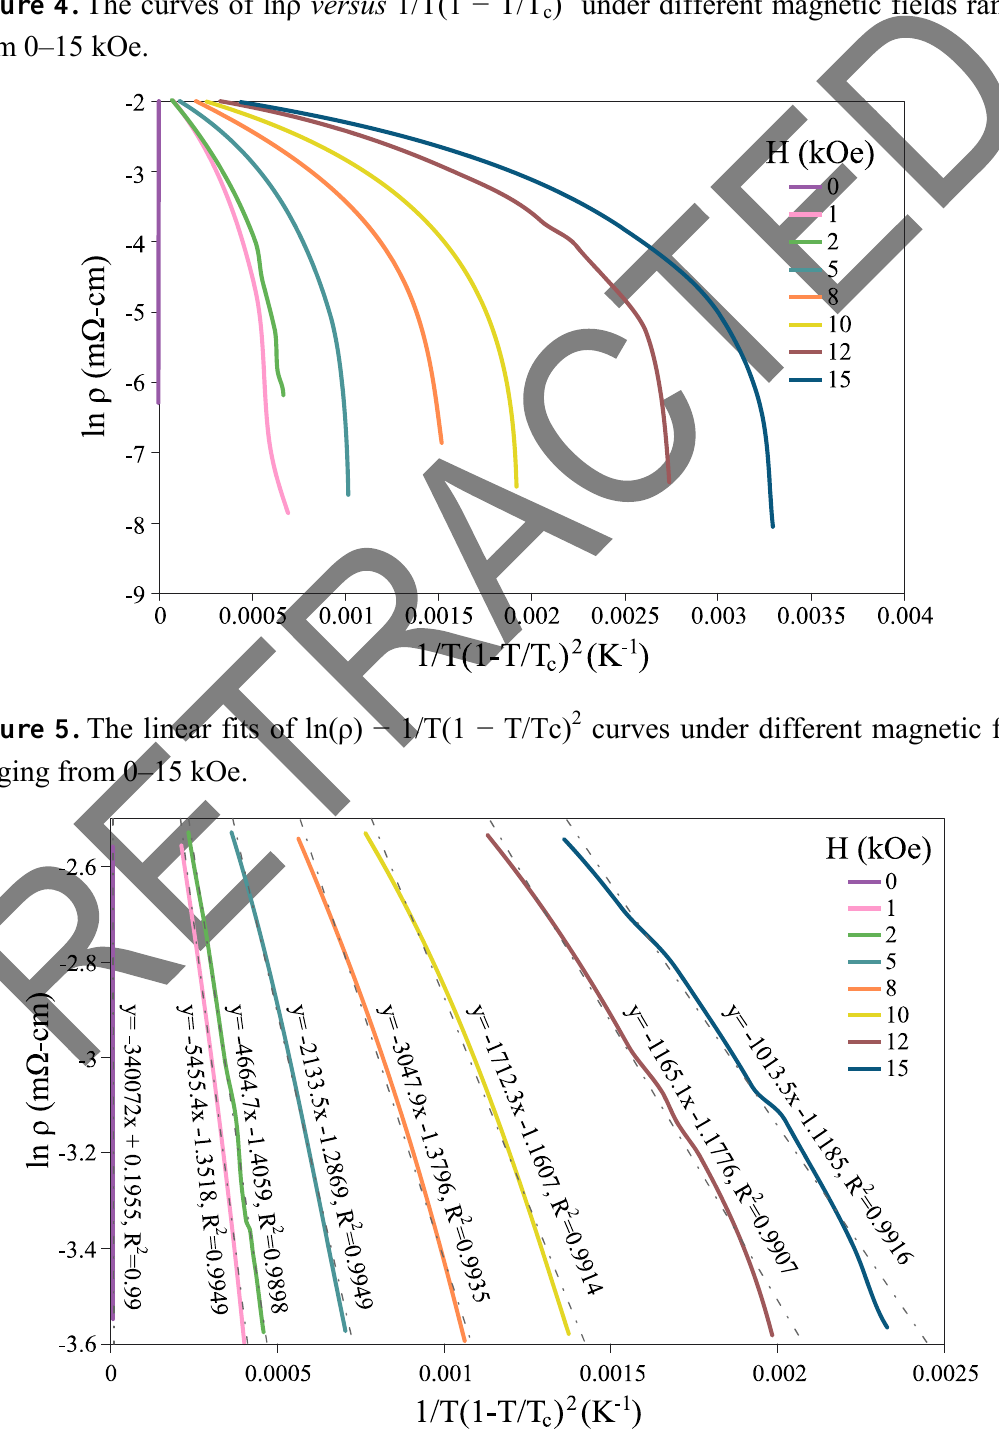
Figure 4. The curves of ln ρ versus 1/T(1 − T/T from 0–15 kOe.